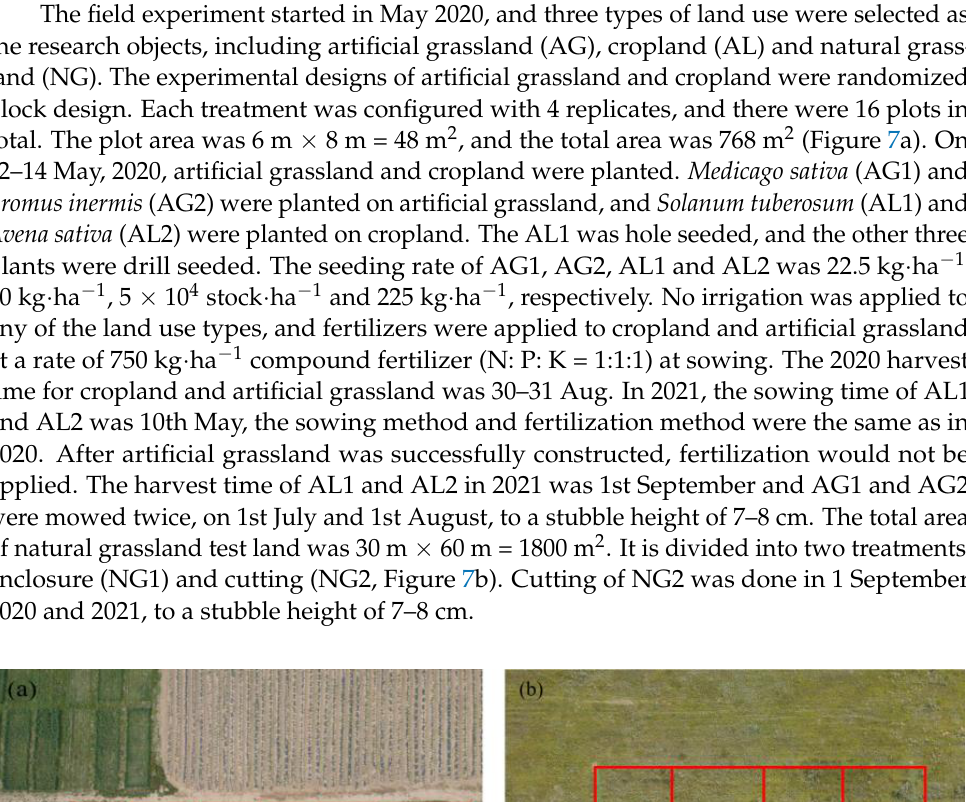
Figure 6. Soil particle distribution. AG: artificial grassland; AL: cropland; NG: natural grassland.